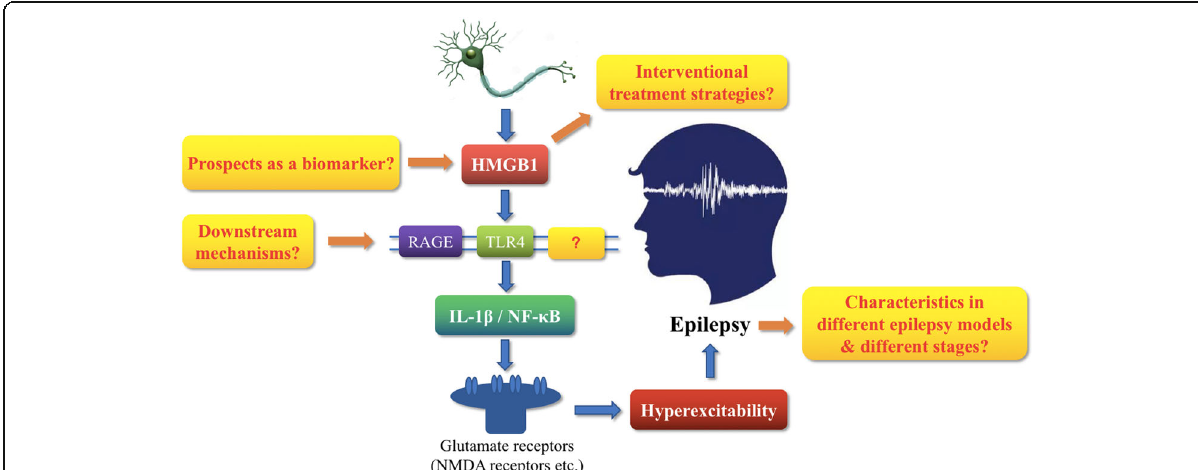
Fig. 1 Perspectives on the role of HMGB1 in epilepsy. HMGB1 exerts its epilepsy-promoting effects mainly by acting on receptors such as TLR4 and RAGE, activating their downstream IL-1 β and NF- κ B, which in turn act with glutamate receptors such as NMDA receptors to promote hyperexcitablilty and epilepsy. However, many questions remain to be resolved as listed in the